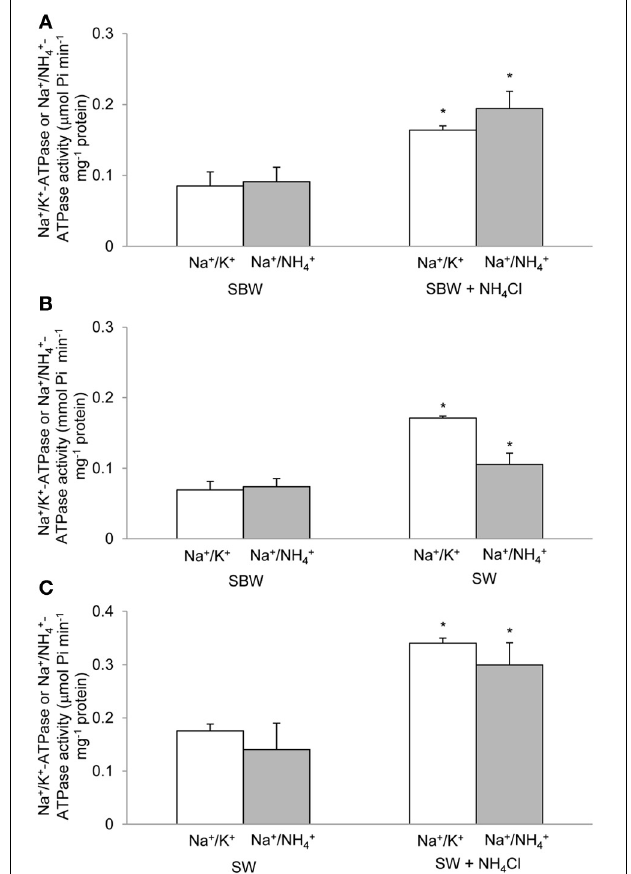
FIGURE 2 | K m (for Na + , K + , or NH + 4 ) of Na + /K + (NH + 4 )-ATPase under various experimental conditions. Effects of 6-days exposure to (A) slightly brackish water (SBW; salinity 3) containing 75mmol l − 1 NH 4 Cl, (B) seawater (SW; salinity 30), or (C) SW containing 50mmol l − 1 NH 4 Cl on K m (for Na + , K + , or NH + 4 ) of Na + /K + (NH + 4 )-ATPase (mmol l − 1 ) from gills of Periophthalmodon schlosseri which had been kept in SBW for 2 weeks. Results represent mean ± s.e.m. ( N = 4). ∗ Significant difference from the K m for NH + 4 of Na + /K + (NH + 4 )-ATPase of the corresponding control ( P < 0 . 05).